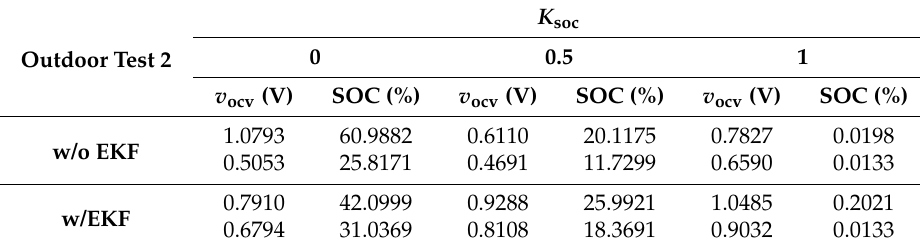
Table 3. Outdoor test result (10 kg payload).